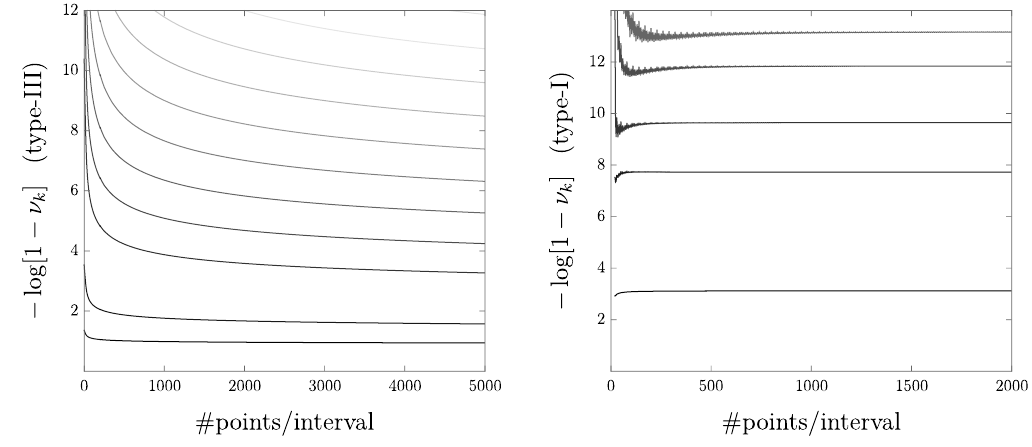
Figure 2 . We plot the \leading" eigenvalues of D j A and C AA (cid:3) (as de(cid:12)ned in the main text) corresponding, respectively to: the correlators matrix required for the evaluation of the usual type- III entanglement entropy for a single interval and the re(cid:13)ected entropy R ( A; B ) for a (cid:12)xed value of the cross-ratio (cid:17) = 25 = 36, for di(cid:11)erent numbers of lattice points. The plot is logarithmic to make the behavior of the di(cid:11)erent eigenvalues more